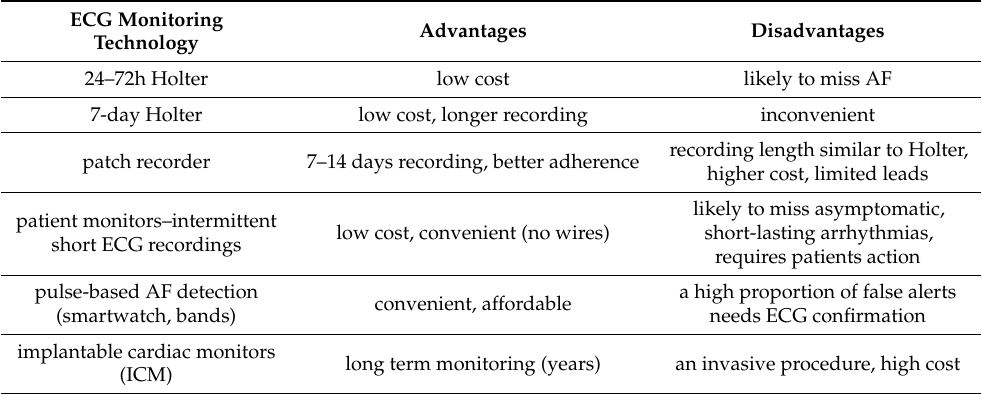
Table 6. Advantages and disadvantages of ECG monitoring strategies for detection of atrial